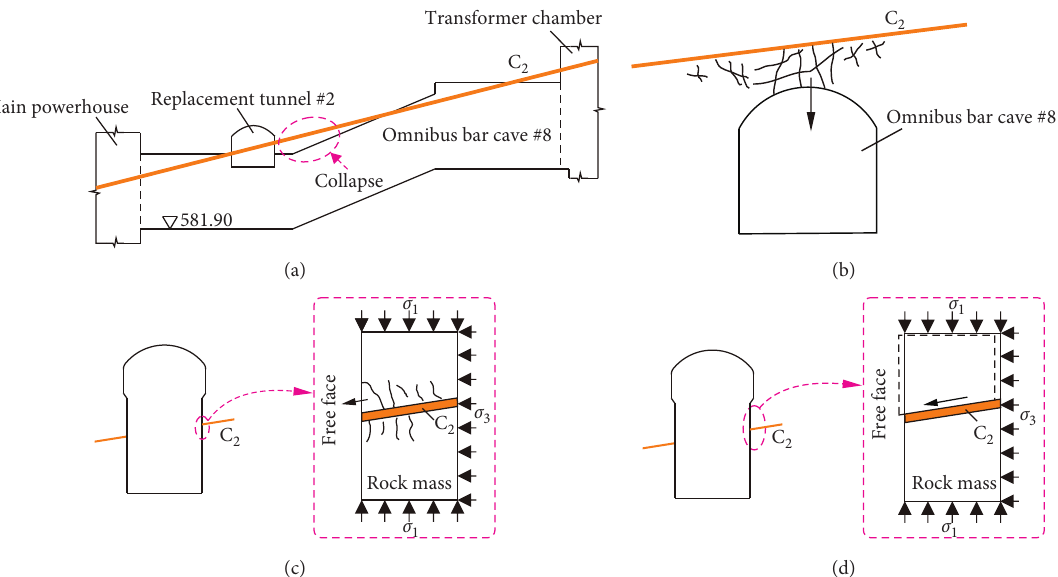
Figure 9: Mechanism diagrams of rock collapse and shear deformation: (a) schematic diagram of the spatial position relationship between omnibus bar cave #8 and C 2 ; (b) mechanism diagram of the collapse along C 2 of surrounding rock mass at the arch crown; (c) mechanism diagram of the collapse and failure along C 2 of the surrounding rock mass of the cavern sidewalls; (d) mechanism diagram of the shear slip failure along C 2 of the main powerhouse